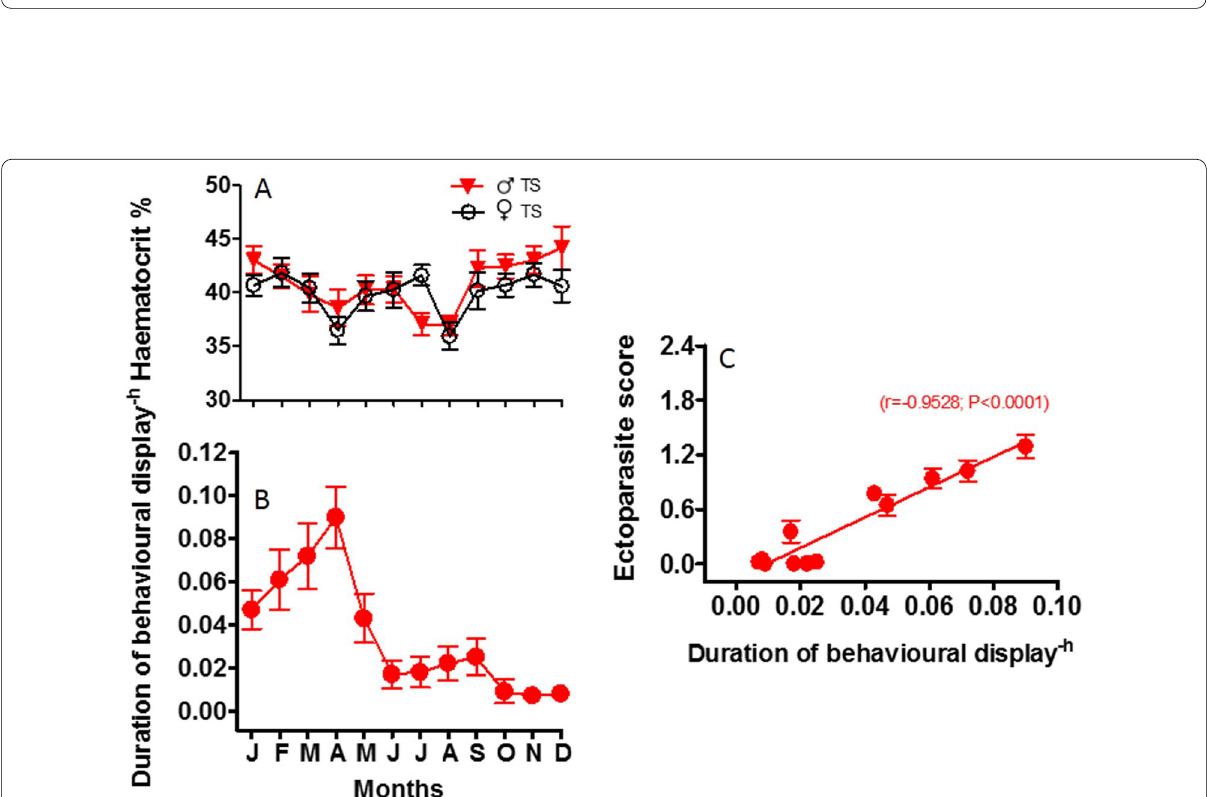
Fig. 4 Annual variations in hematocrit % ( A ) and duration of behavioral display per hour ( B ) in the tree sparrow. Correlation between ectoparasite score and duration of behavioral display per hour ( C